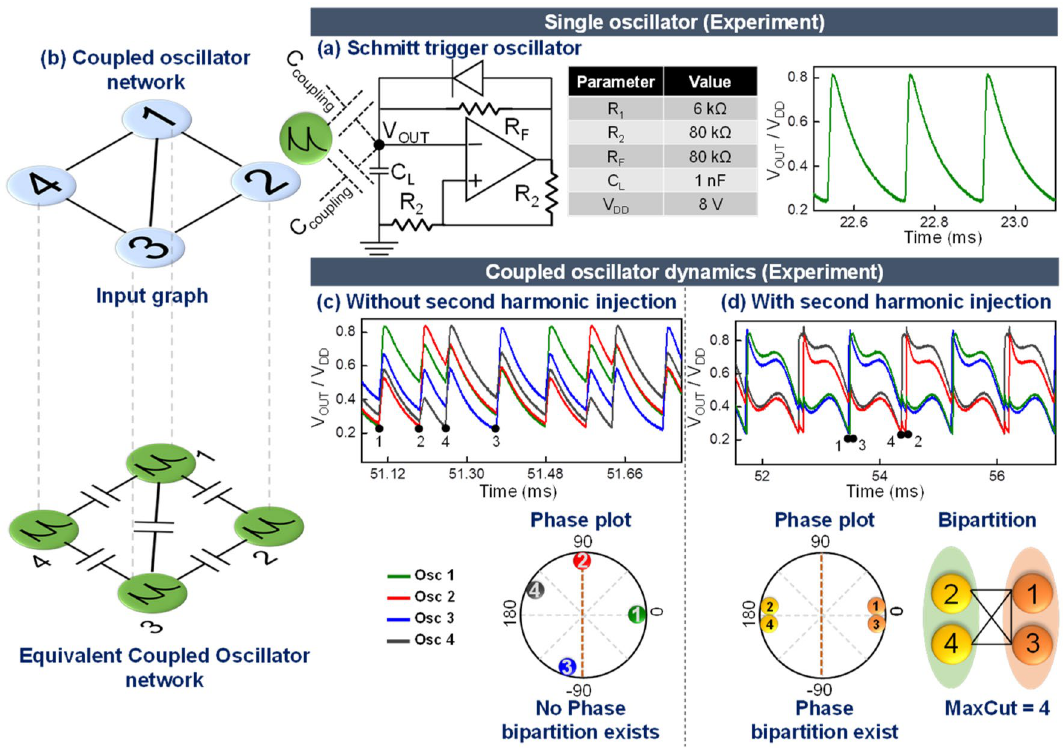
Figure 1. Coupled oscillators as an Ising machine. ( a ) Schematic of the Schmitt-trigger based relaxation oscillator and the corresponding experimentally measured time domain output. ( b ) Illustrative graph, and the corresponding coupled oscillator circuit implementation to compute the MaxCut. ( c , d ) Time domain outputs and corresponding phase plots for a coupled system of oscillators (corresponding to the input graph on the left) with and without external second harmonic injection, respectively. It can be observed that the second harmonic signal is needed to realize the (Ising model-relevant) bipartition in the oscillator phases, required to solve the MaxCut problem. Without the second harmonic signal, the oscillator phases exhibit a continuous phase